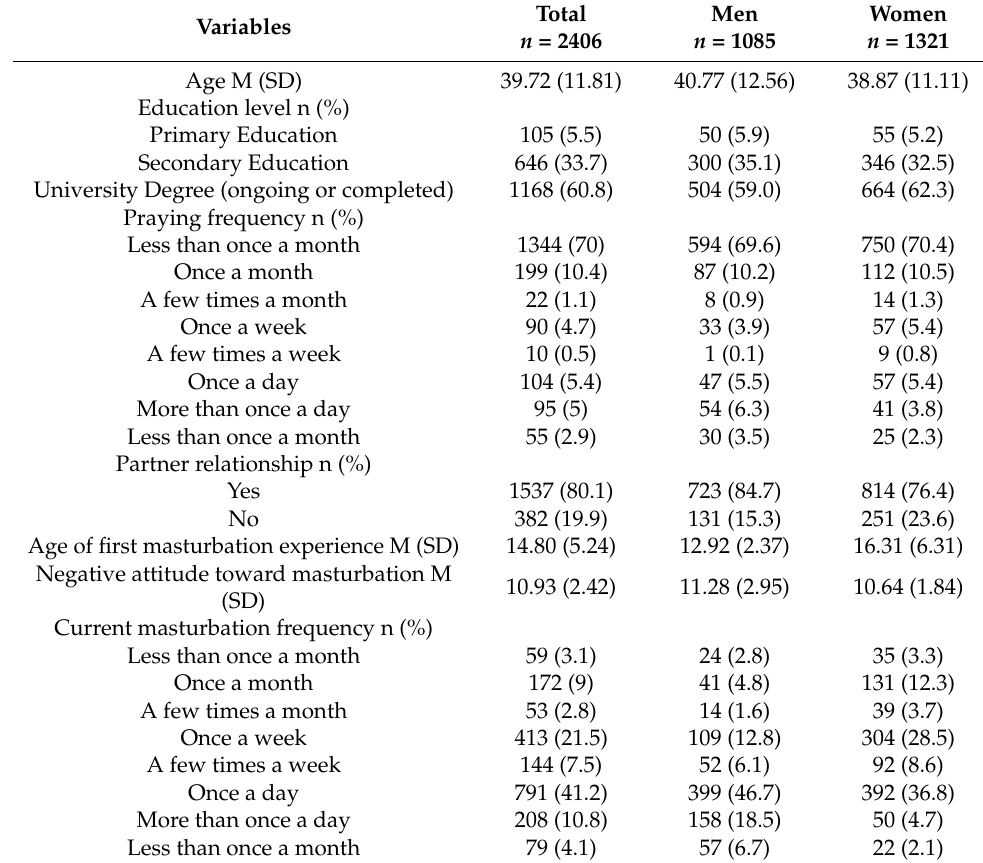
Table 1. Sociodemographic characteristics of the participants in Study 1.